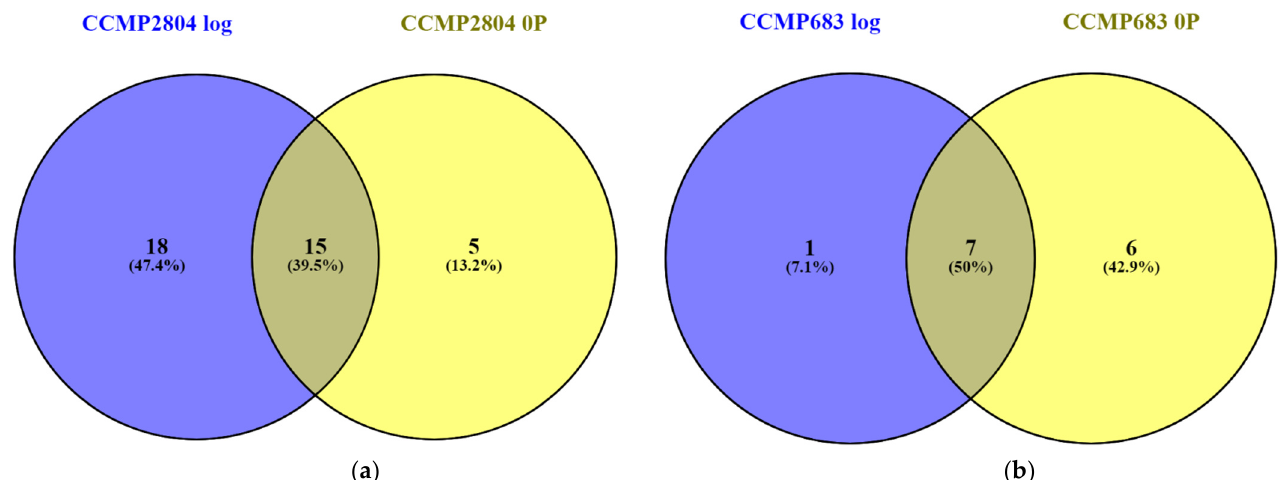
Figure 3. Number of protein spots showing at least two-fold differences in intensity between CCMP2804 and CCMP683 with normal nutrient supply in log phase (log) versus under 0P on day 50: ( a ) upregulated spots in CCMP2804; ( b ) upregulated spots in CCMP683. The area of overlapping shows differential spots commonly found during log and under 0P.